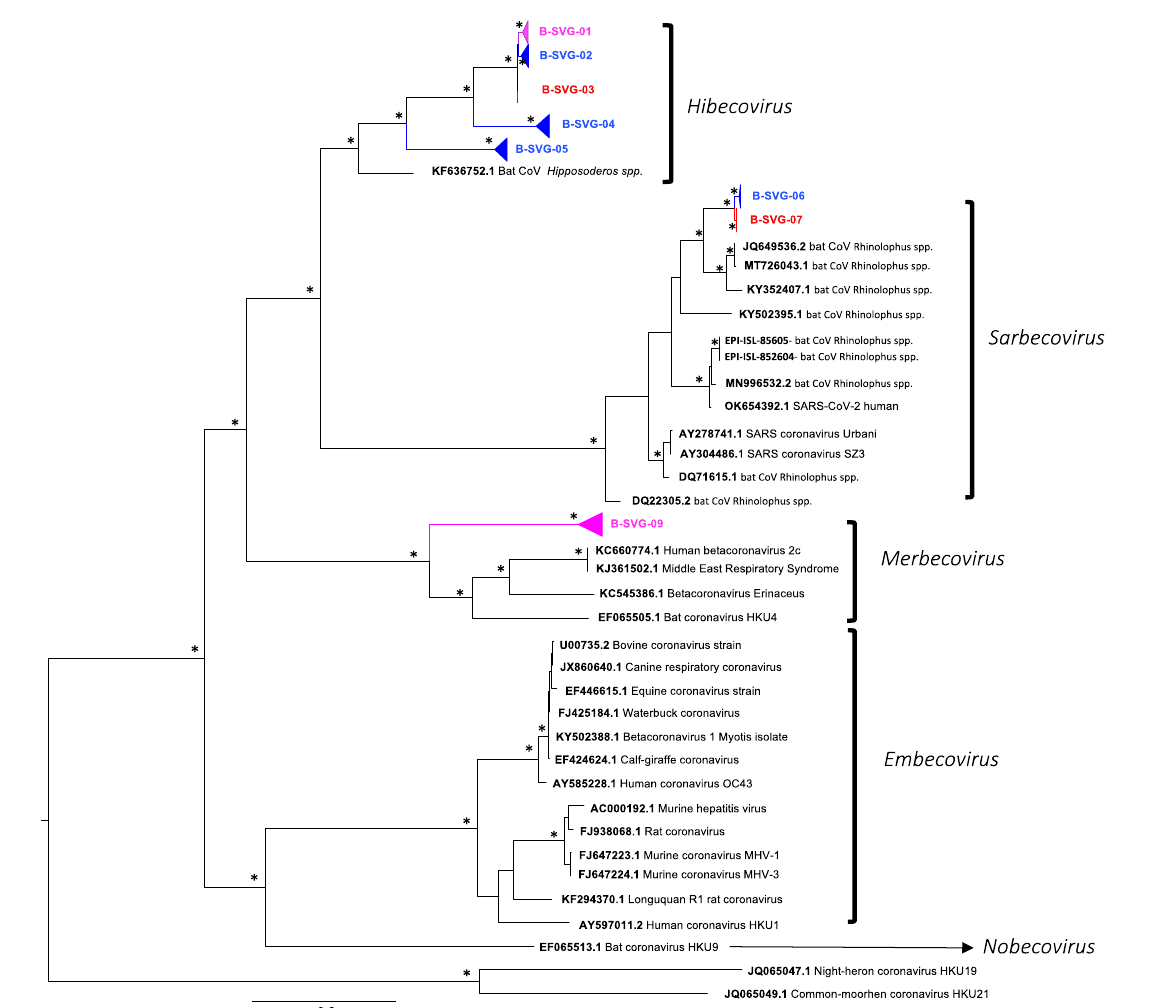
Figure 4. Phylogenetic tree of BetaCoV partial RdRp gene. The sequences detected at Chirundu site are in red color and at Magweto site in blue color. Pink = more sequences detected at Chirundu than Magweto site within the same subclade. The tree was built using the maximum likelihood method based on the GTR + G4 + I model. The robustness of nodes was assessed with 1000 bootstrap replicates. Bootstrap values >70 are denoted with asterisks, and those <70 are not shown.